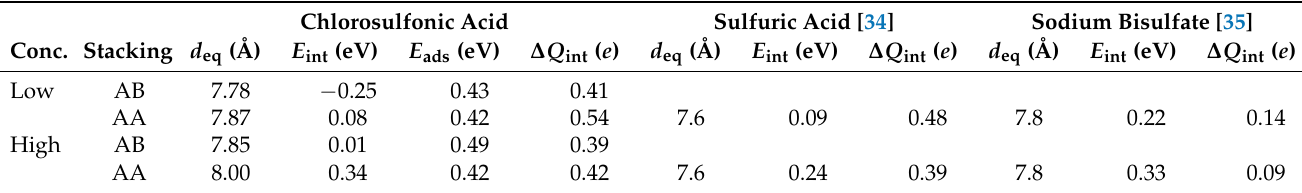
Table 4. Calculated equilibrium interlayer distance ( d eq ), intercalation ( E int ) energy into BLG, adsorption energy ( E ads ) on BLG, electron transfer from the graphene bilayer to each acid molecule ( ∆ Q int ) for chlorosulfonic and sulfuric [34] acids, for sodium bisulfate [35], and two concentrations: low (one molecule per 64 carbon atoms) and high (one molecule per 36 carbon